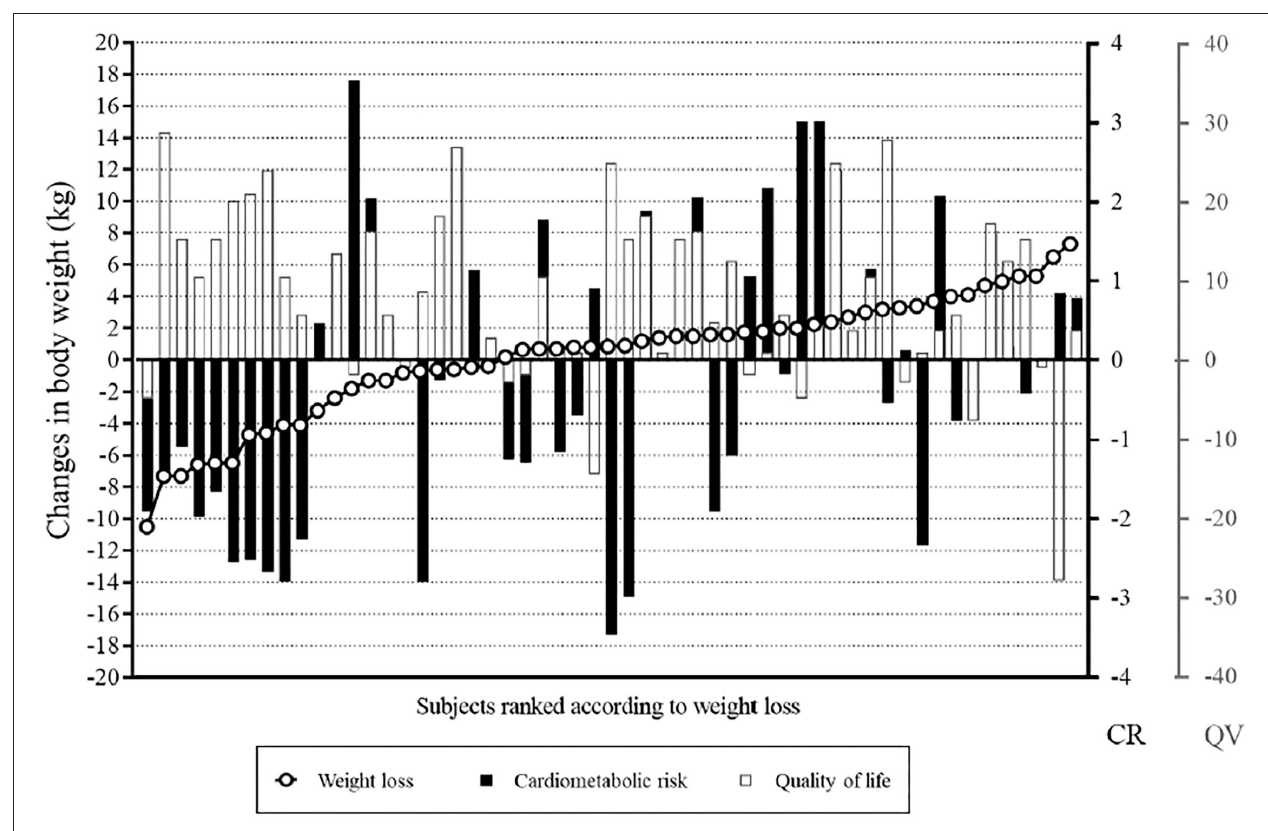
FIGURE 1 | Individual data for changes in body weight, clustered cardiometabolic risk, and quality of life. Although the participants who lost more weight showed greater health improvements (those on the left side), benefits in cardiometabolic risk and quality of life can be seen all across the spectrum of changes in body weight. CR, cardiovascular risk: negative values mean improvement; QL, quality of life: positive values mean improvement.